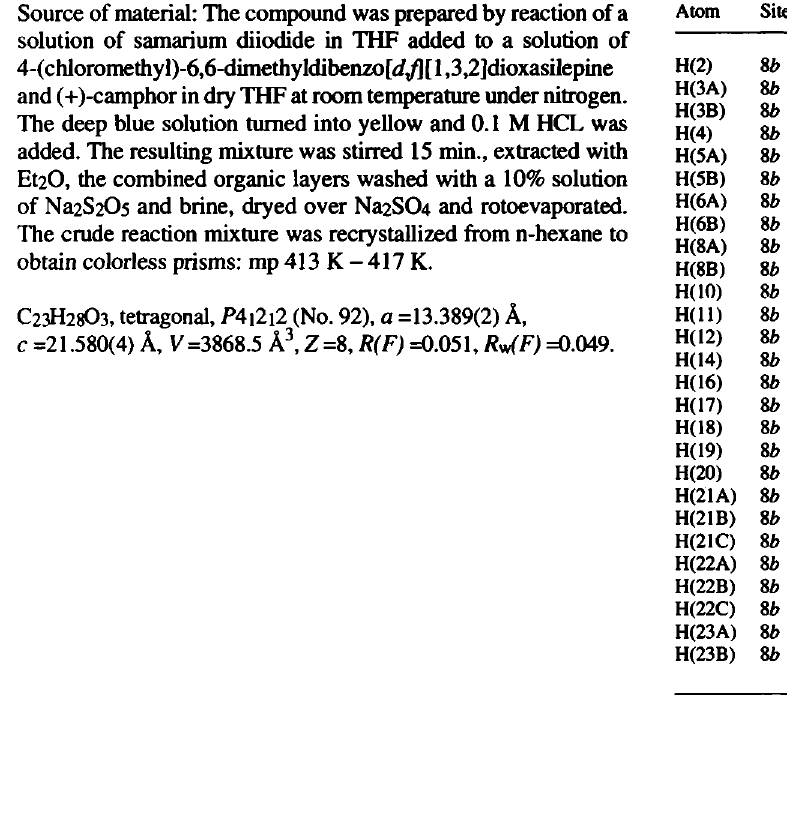
Table 2. Fmal atomic coordinates and displacement parameters (in